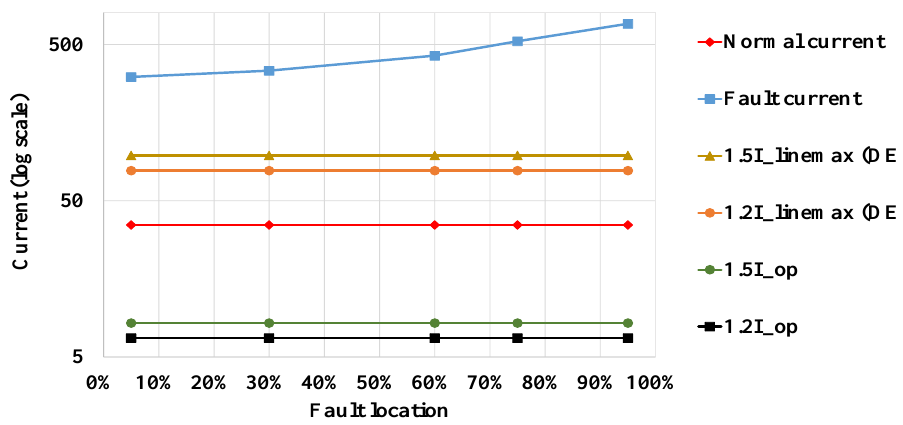
Figure 16. Fault condition at different locations with 70% load and 1 Ω fault